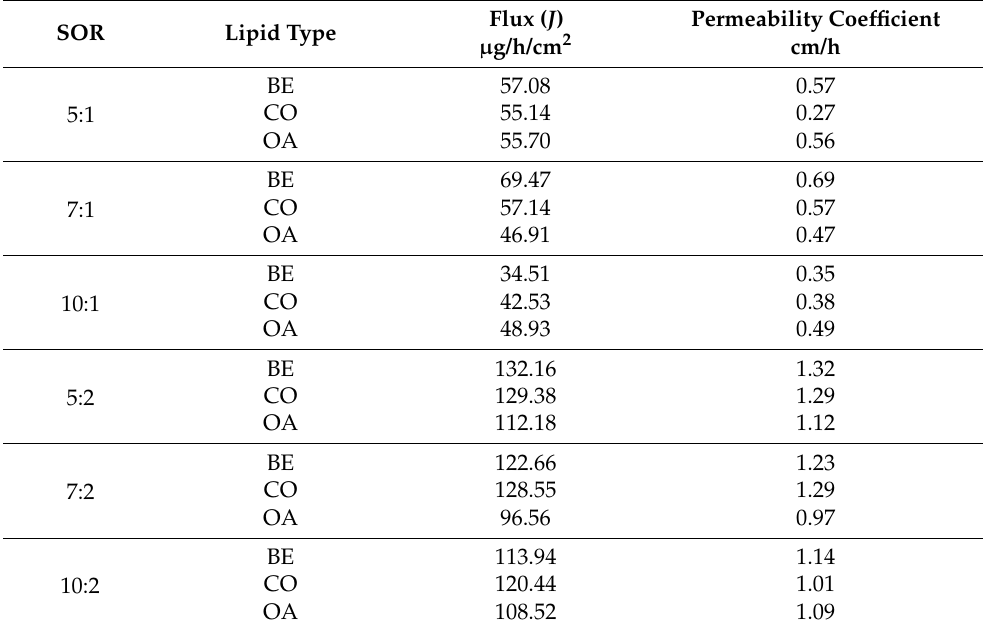
Table 1. Flux values and permeability coefficient for lidocaine nanoemulsions through PDMS mem-